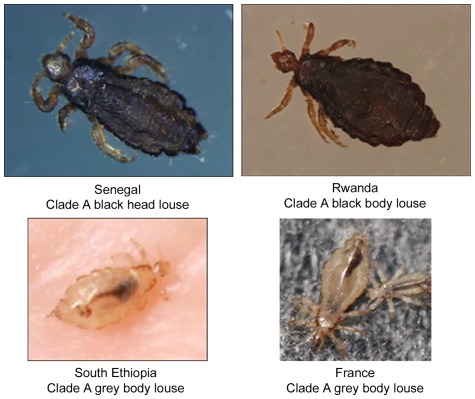
Pictures of lice.